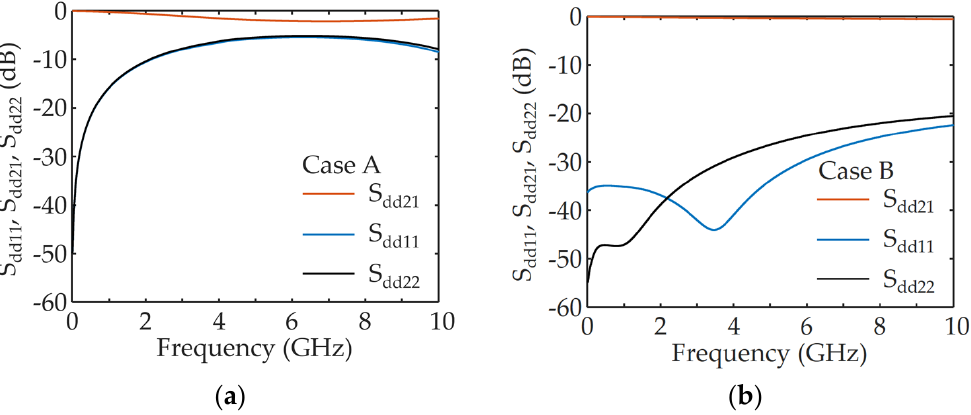
Figure 10. Mixed-mode S-parameters for ( a ) case A and ( b ) case B. Table 4. Example of simulation time comparison.